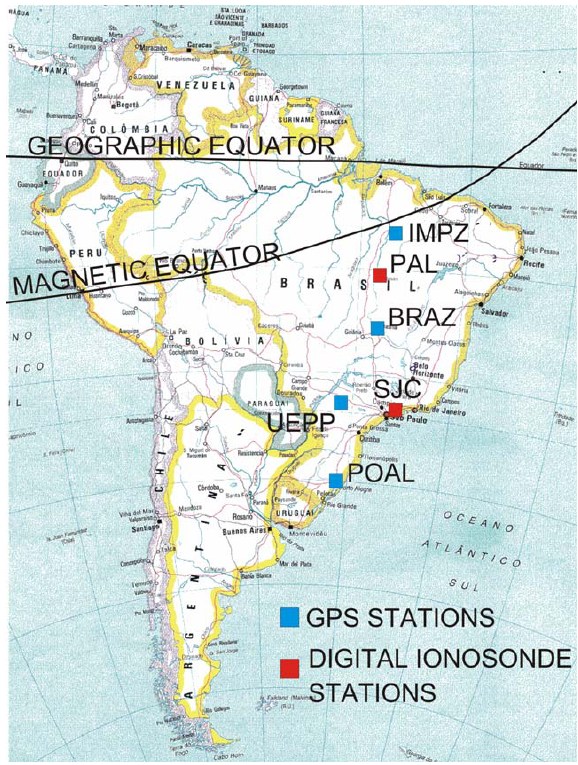
Fig. 1. Map of South America showing the locations of the iono- spheric sounding (red marks) and GPS (blue marks) stations. In addition, the geographic and magnetic (based on IGRF-9, 2000) equators are